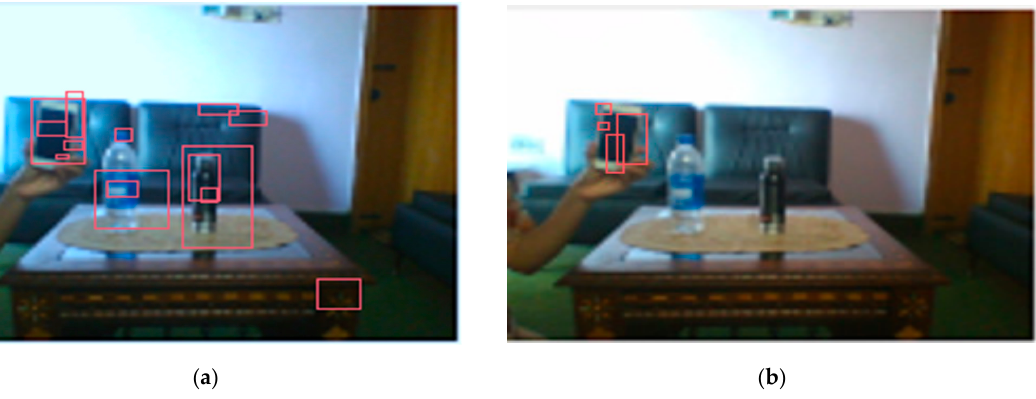
Figure 4. ( a ) PSA initial performance in a multicycle environment (bottom-up attention). This experiment defines that in a bottom-up attention process, PSA system will generate attention on every prominent feature of the object. ( b ) PSA initial performance in a multicycle environment (top-down selective attention). This experiment defines the PSA attention process on only the targeted objects. Here, PSA is asked to pay attention only to mobile objects. So, PSA recognizes the object that was asked for as a priority and pays its full attention to the mobile object.